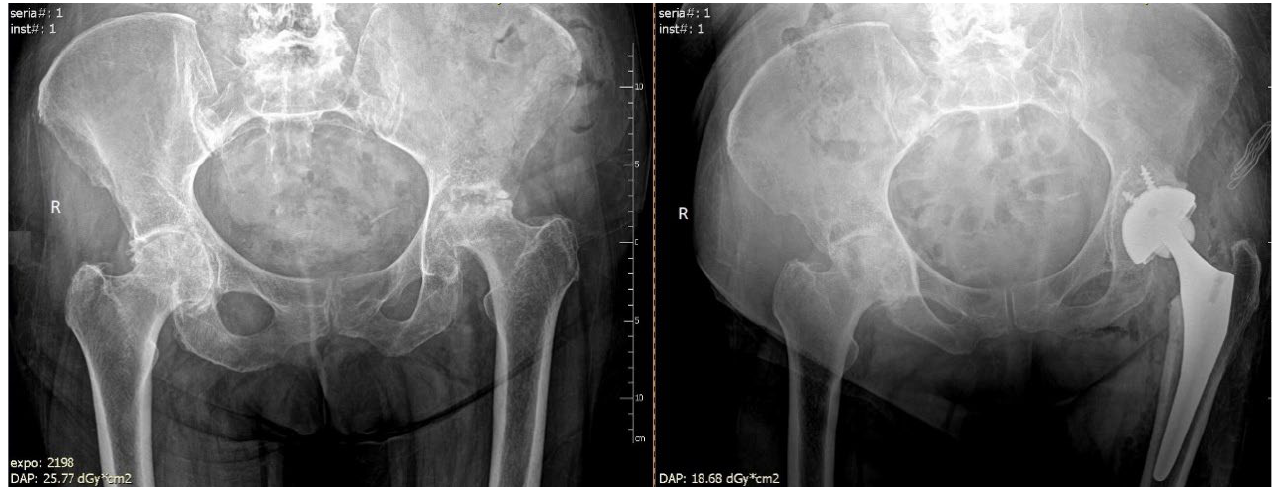
Figure 4. Arthroplasty of the left hip due to avascular necrosis of the femoral